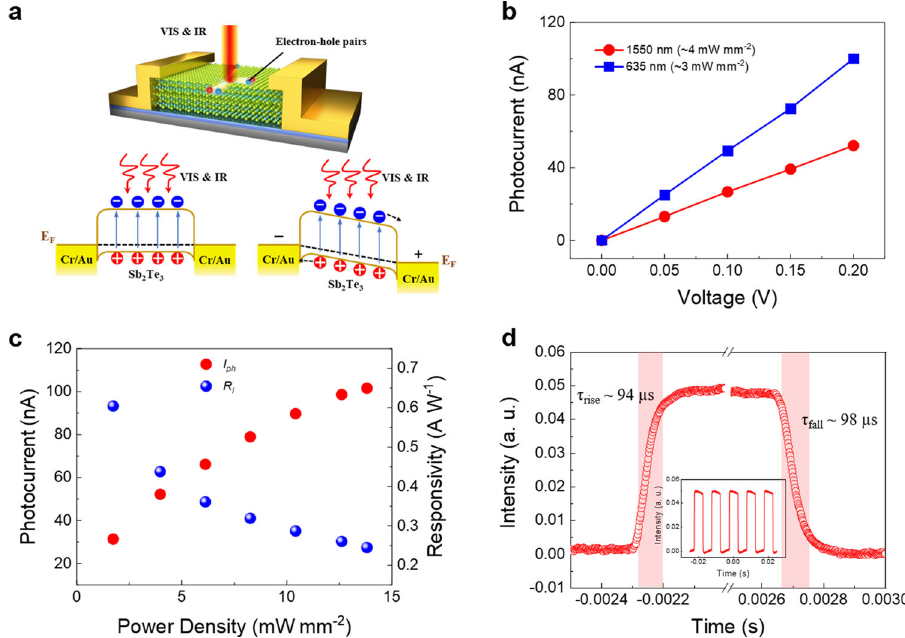
Fig. 2 Response mechanism and performance of the Sb 2 Te 3 photodetector in the VIS and IR bands. a Schematic of the structure and response mechanism under VIS and IR radiation. b Photocurrent of the photodetector at 635 nm and 1550 nm with different bias voltages. c Photocurrent and responsivity of the photodetector as a function of powers with a bias voltage of 0.2 V. d Response speed at 635 nm radiation. The inset: the oscillogram under periodic 635 nm